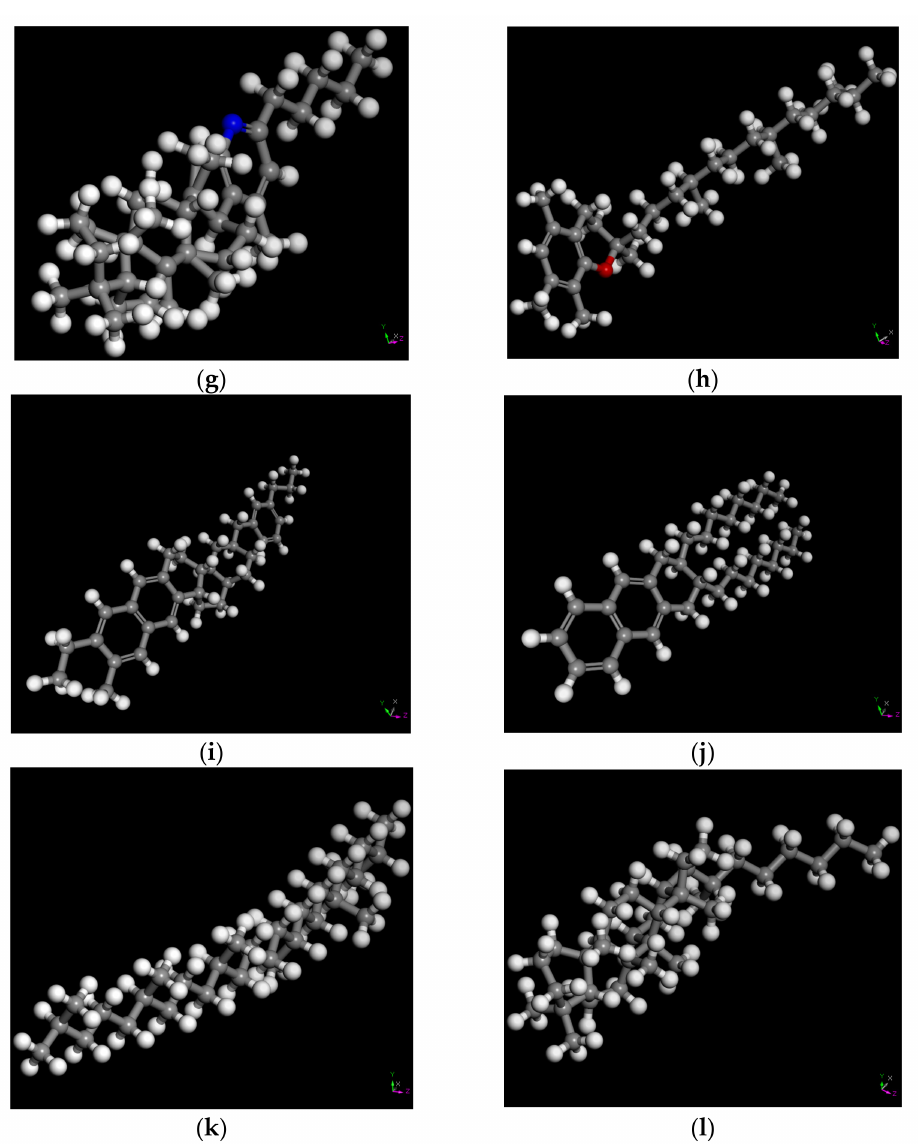
Figure 2. Molecular models of base asphalt. ( a ) Asphaltene A, ( b ) Asphaltene B, ( c ) Asphaltene C,